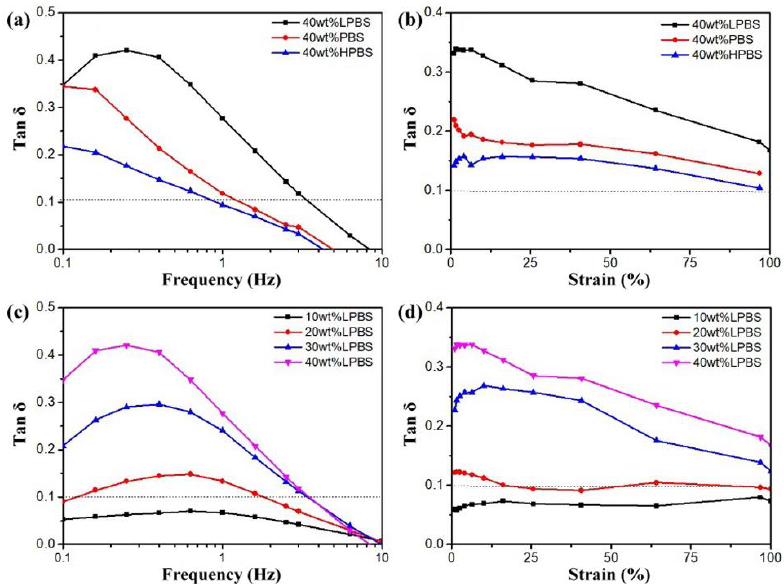
Figure 8. ( a , b ) are the loss factors graph with changes in strain of LPBS, PBS and HPBS compound silicone rubber at different frequencies. ( c , d ) are the graphs of the loss factors of LPBS-gel compound silicone rubber with different contents as a function of frequency and strain.